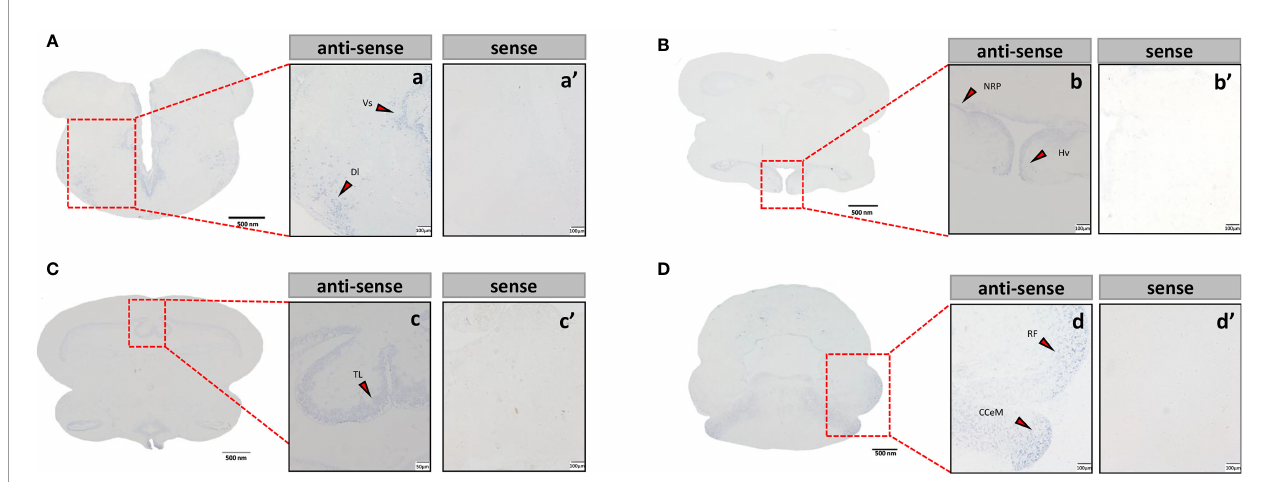
FIGURE 6 | Tac3b mRNA in the brain of Japanese eel was detected by in situ hybridization (ISH). Tac3b localization in the telencephalon. Tac3b localization in the telencephalon (A) , thalamus (B) , midbrain (C) , and cerebellum (D) . Scale bar = 500 m m. Positive signal of tac3b in the telencephalon (a) , thalamus (b) , midbrain (c) , and cerebellum (d) . Negative signals of tac3a with sense probe results in the telencephalon (a ’ ) , thalamus (b ’ ) , midbrain (c ’ ) , and cerebellum (d ’ ) . a, a ’ , b, b ’ , c ’ , d, d ’ : Scale bar = 100 m m. c: scale bar = 50 m m. Dl, the lateral part of the dorsal telencephalon; Vs, the supracommissural nucleus of the ventral telencephalon; Hv, the ventral hypothalamus; NRP, the nucleus of the posterior recess; TL, the torus longitudinalis; RF, the reticular formation; CCeM, the molecular layer of corpus cerebelli.